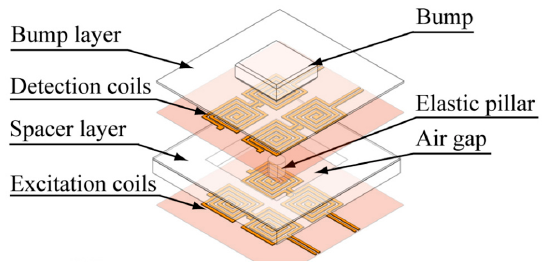
Figure 9. The structure diagram of the tactile sensor with coils (designed by Wattanasarn). Reprinted with permission from Ref. [77]. Copyright 2012, IEEE.